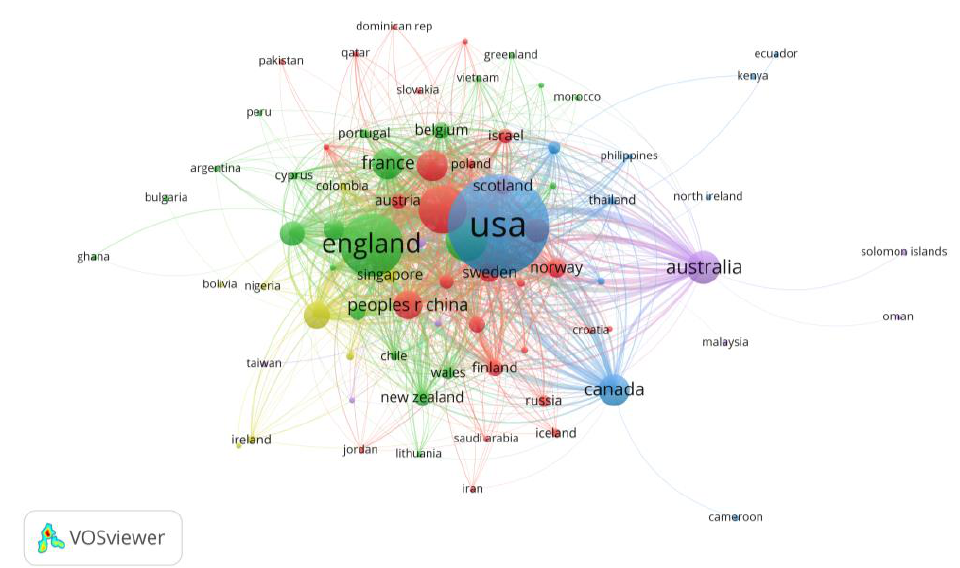
Figure 5. The bibliographic coupling network visualization of countries. The green cluster contains 23 countries, most notably England, which was also the earliest country to start research and application of nudge. The rest of the cluster is dominated by European countries (e.g., France, Switzerland, Belgium, Portugal, etc.), Asian countries (e.g., Vietnam, Korea), and Oceanic countries (e.g., New Zealand). These countries have cited similar articles in their nudge studies. Twenty-eight countries in the red cluster are spread out, ranging from European countries such as Germany, Italy, Sweden, and Norway, to Asian countries such as China, India, and Japan, and American countries such as Brazil and the Dominican Republic. In addition to being geographically distant, these countries are cited in similar articles. Regarding the relatively sparser clusters, Australia and Denmark are most visible in the purple and yellow clusters,